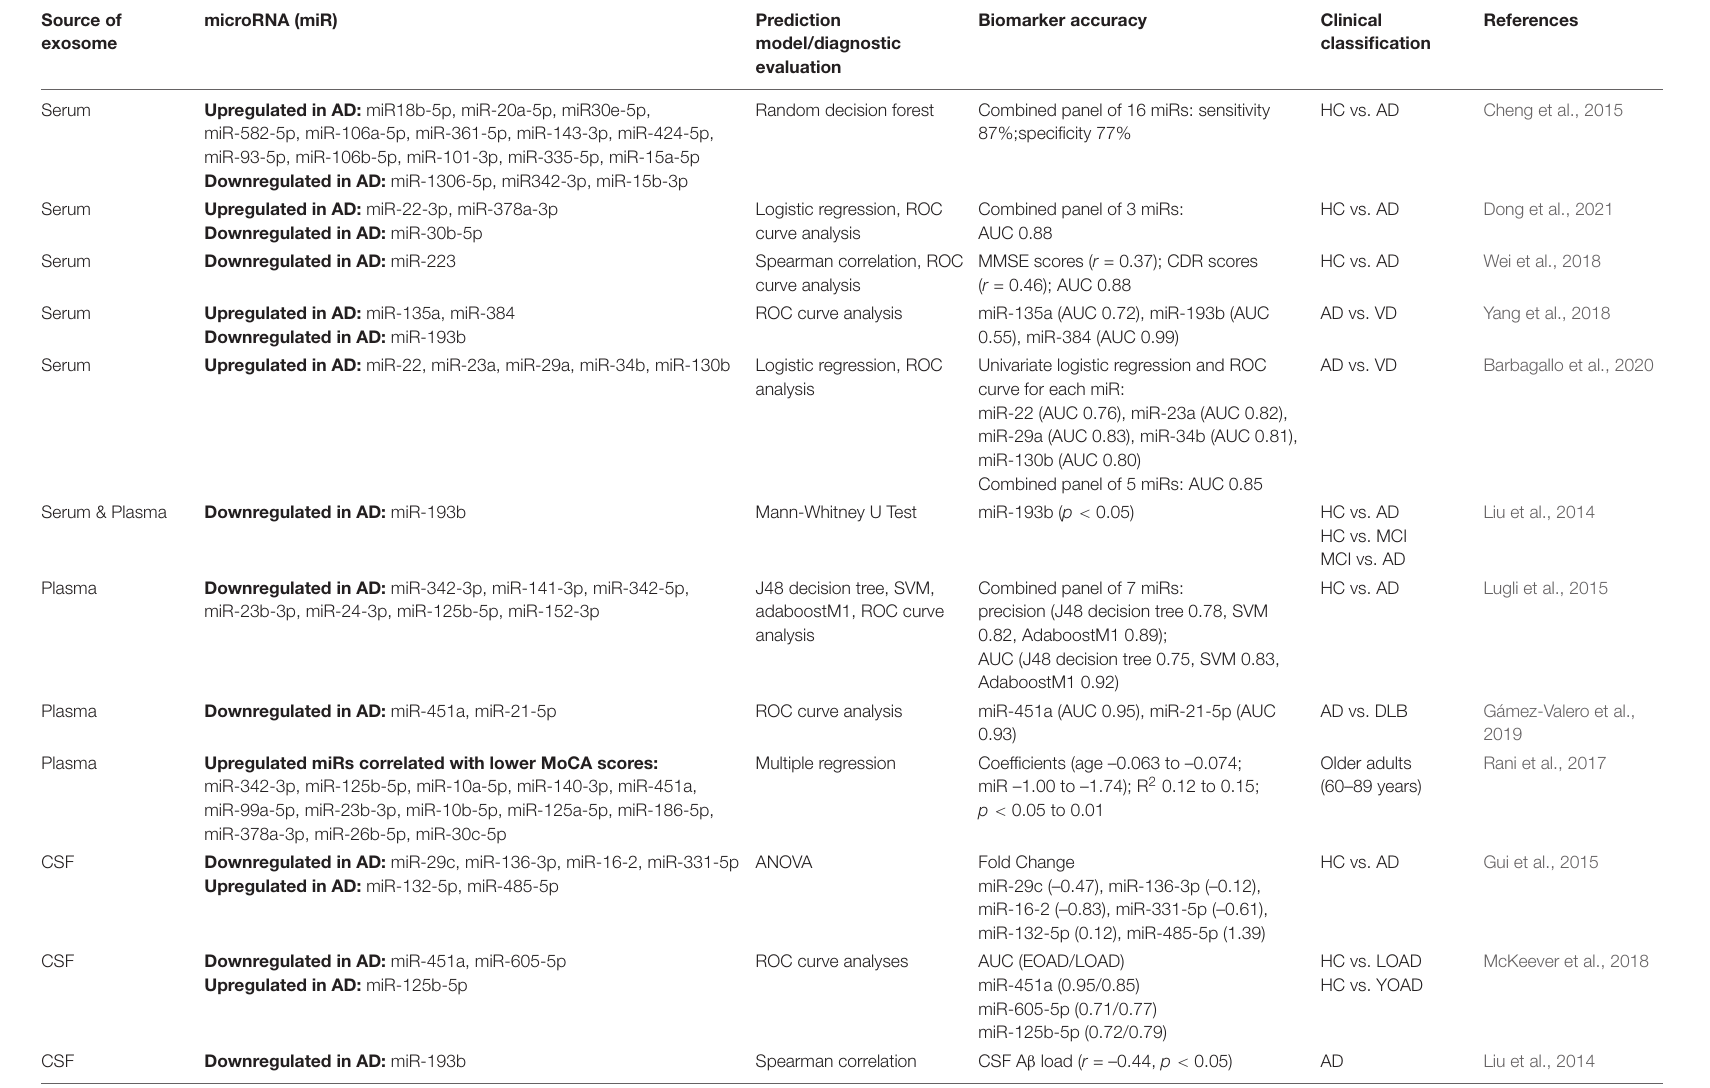
AD, Alzheimer’s Disease; AUC, area under the curve; CDR, clinical dementia rating; CSF, cerebrospinal fluid; DLB, dementia with Lewy bodies; HC, Healthy Controls; LOAD, Late-Onset AD; MCI, mild cognitive impairment; MMSE, Mini-Mental State Examination; MoCA, Montreal Cognitive Assessment; ROC, receiver operating characteristic; SVM, support vector machine, VD, vascular dementia; YOAD, Young-Onset AD. The direction of change in microRNA is indicated in